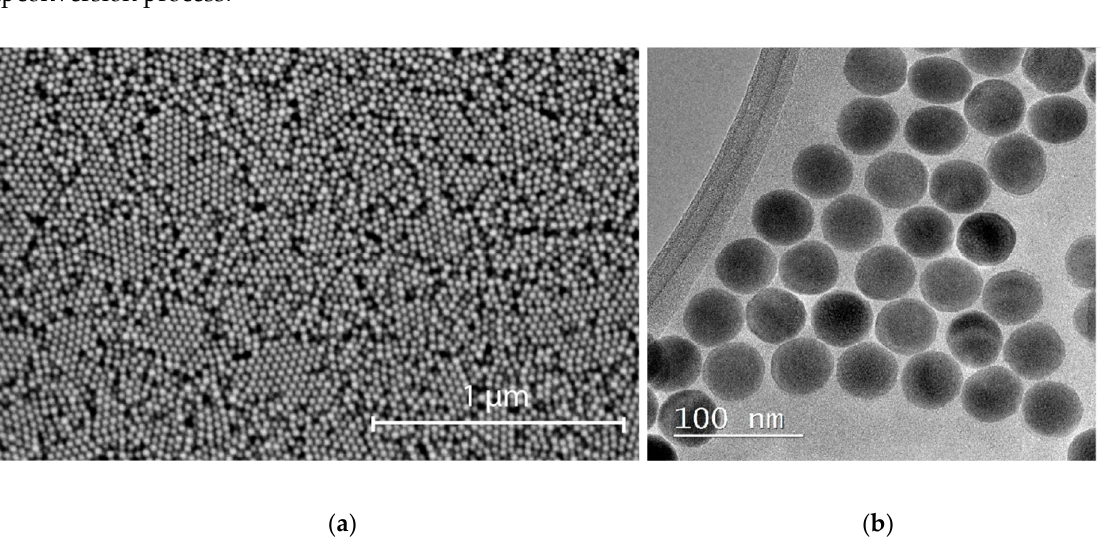
Figure 1. ( a ) SEM and ( b ) TEM images of core/shell NaYF 4 : Yb 3+ , Tm 3+ /NaYF 4 nanoparticles.